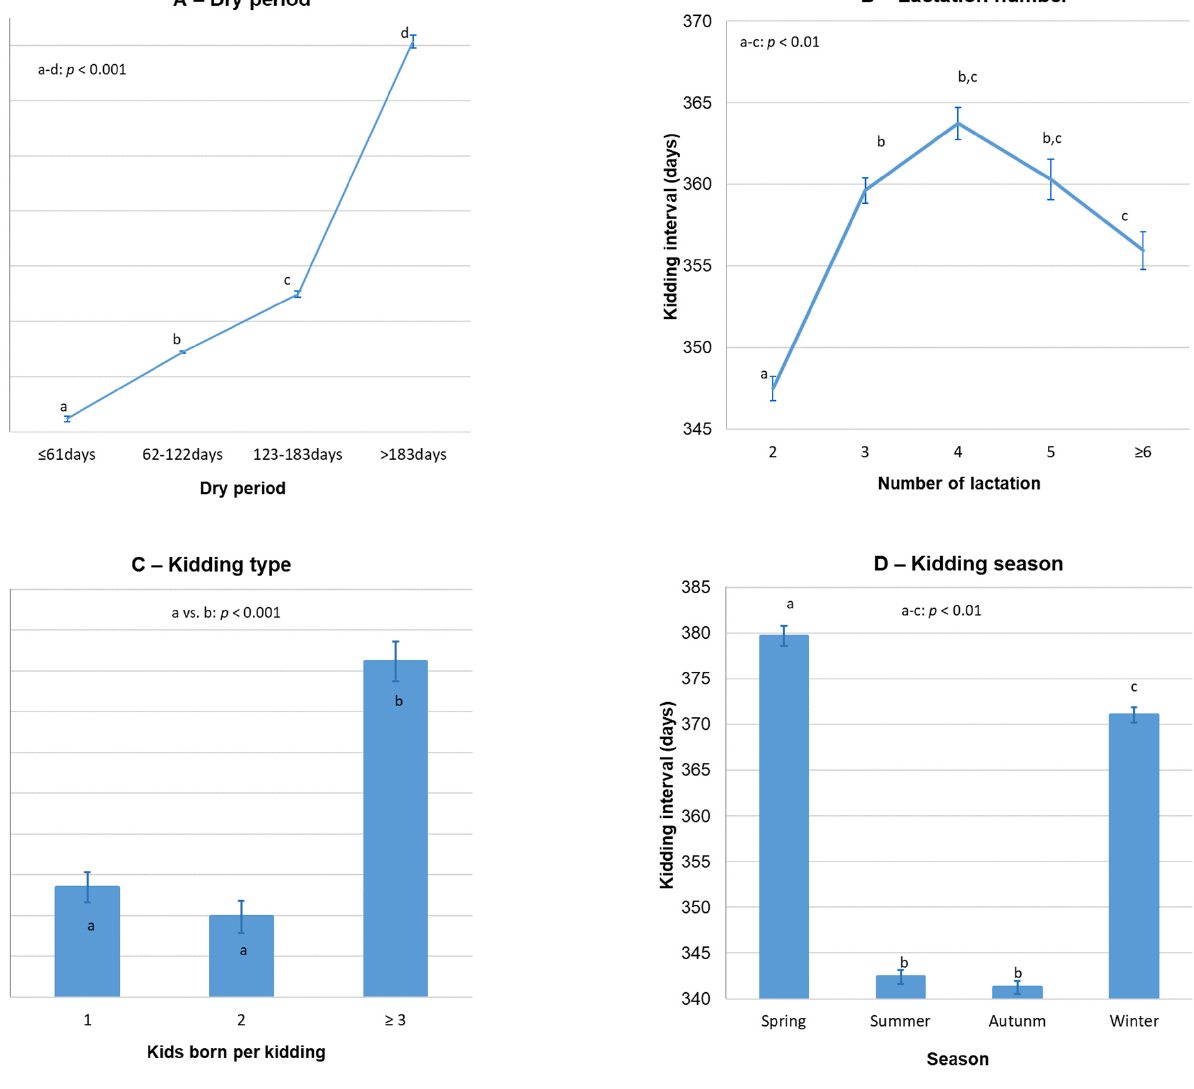
Figure 1. Variation in kidding interval according to dry period ( A ), lactation number ( B ), kidding type ( C ) and kidding season ( D ) of Florida goats. Error bars = ± standard error.